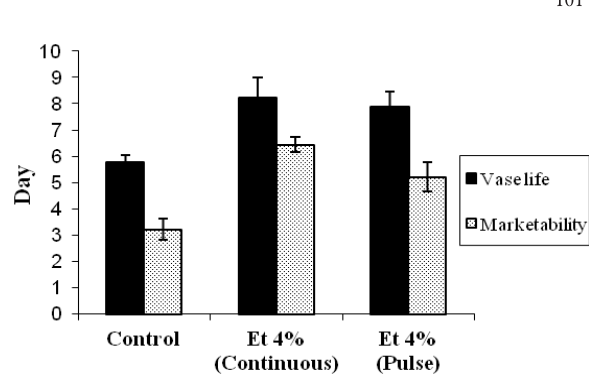
Fig. 2. Effect of continuous and pulse application of 4% Et on vase-life and marketability of carnation cut flowers (cv. ‘Yellow Candy’)